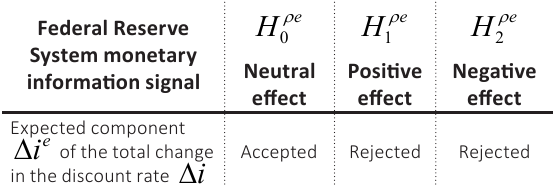
Table 6. Testing results for advanced hypotheses